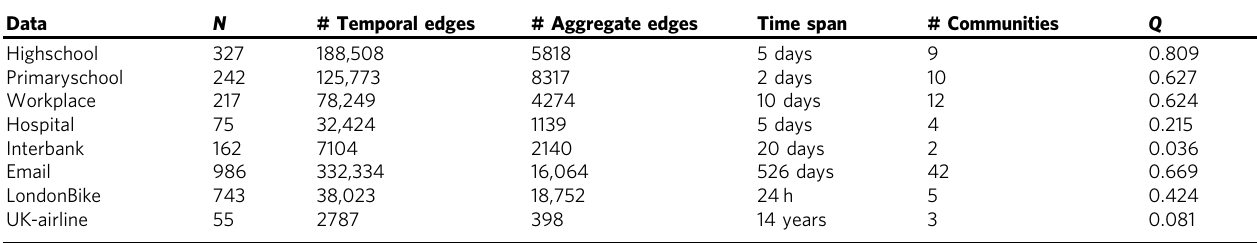
Table 1 Basic description of empirical temporal networks